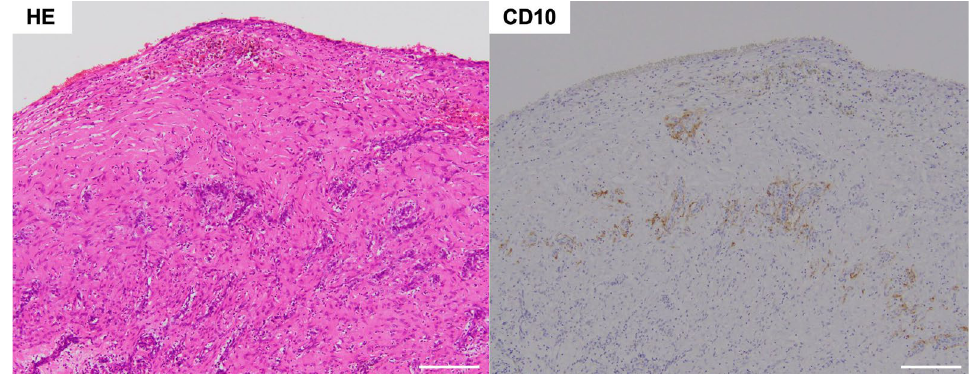
Fig. 9 Hematoxylin–eosin (HE) staining showing congestion, hemorrhage, and infiltration of inflammatory cells and hemosiderin in the cell wall. The resected specimen was also positive for CD10 staining. Scale bar: 200